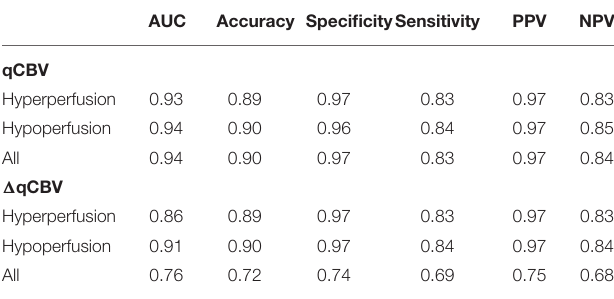
TABLE 4 | The detailed information of ROC